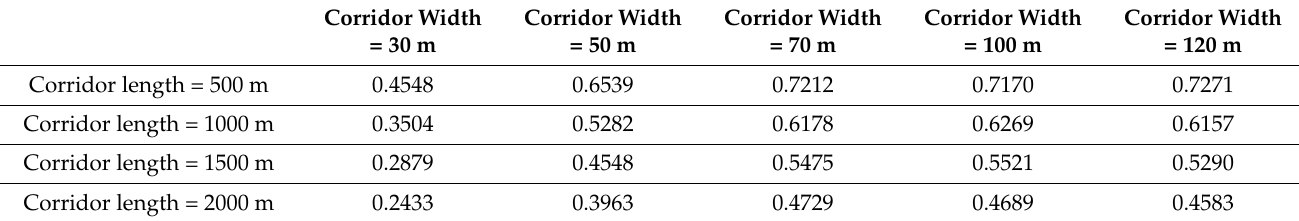
Table 2. The degree of ventilation of the length and width of each corridor when the wind direction was − 45 degrees.